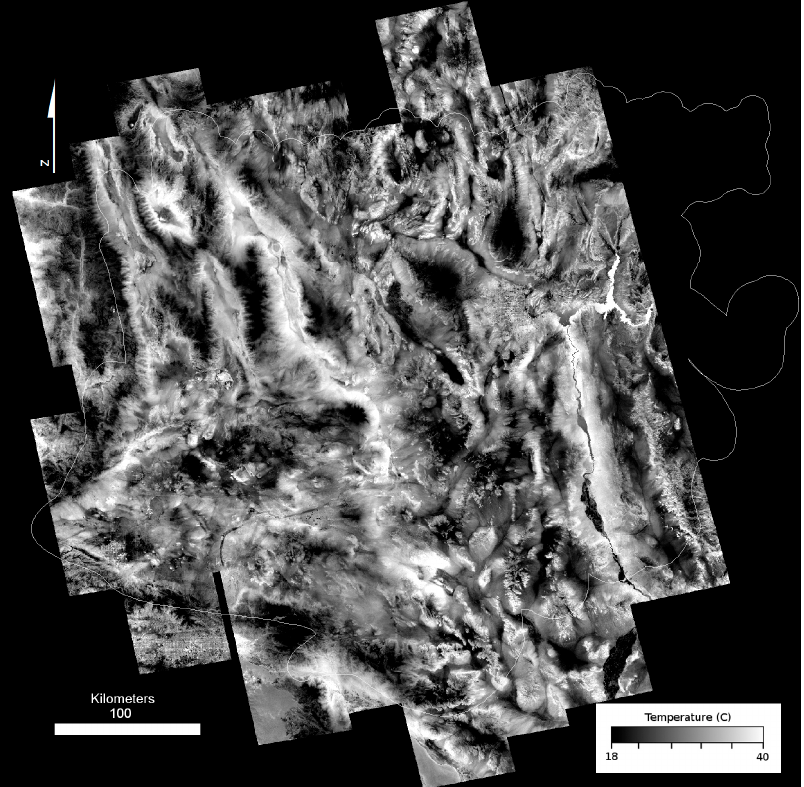
Sensors 2019 , 19 , x FOR PEER REVIEW Figure 5. Nighttime ASTER enhanced Land Surface Temperature (eLST) mosaic. Figure 5. Nighttime ASTER enhanced Land Surface Temperature (eLST) mosaic.